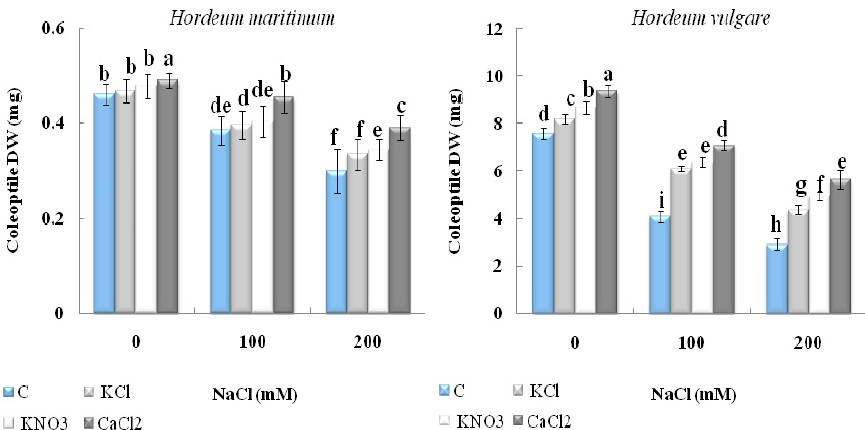
Figure 4. Effect of KCl, KNO 3 , and CaCl 2 seed priming on the dry weight (DW) on the radicle and coleoptile of two barley species, Hordeum maritimum and Hordeum vulgare (L. Manel) , subjected to various salt concentrations (0, 100, and 200 mM NaCl) for 7 days at the germination stage. Values are the means of 10 independent replicates ± standard error. Data with the same letter are not significantly different at p < 0.05 (Duncan’s test).